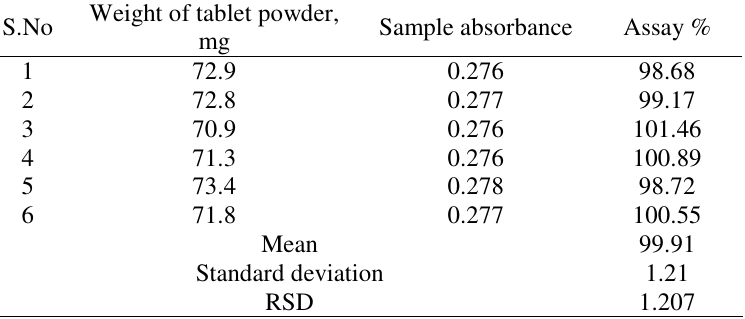
Figure 3. Specificity for metformin HCl Table 1. Assay of metformin